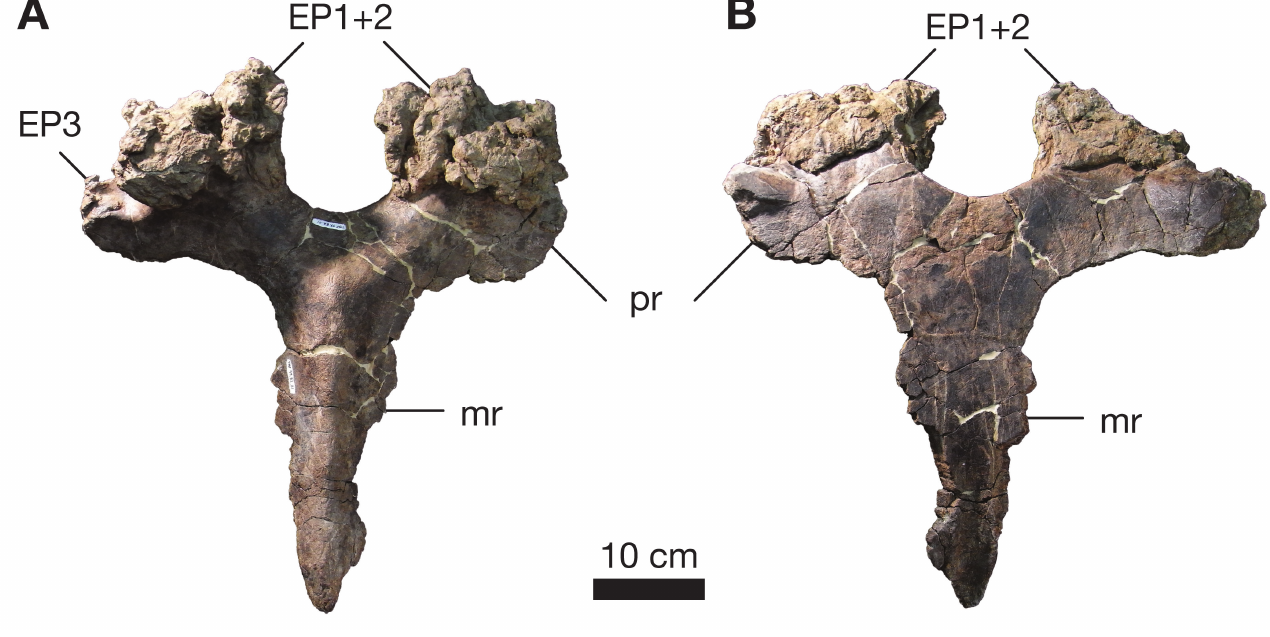
Figure 1. Best preserved parietal from MRRBB (TMP 1999.082.0001): A, dorsal view; B, ventral view. Abbreviations: EP, epiparietal; mr, midline ramus; pr, posterior